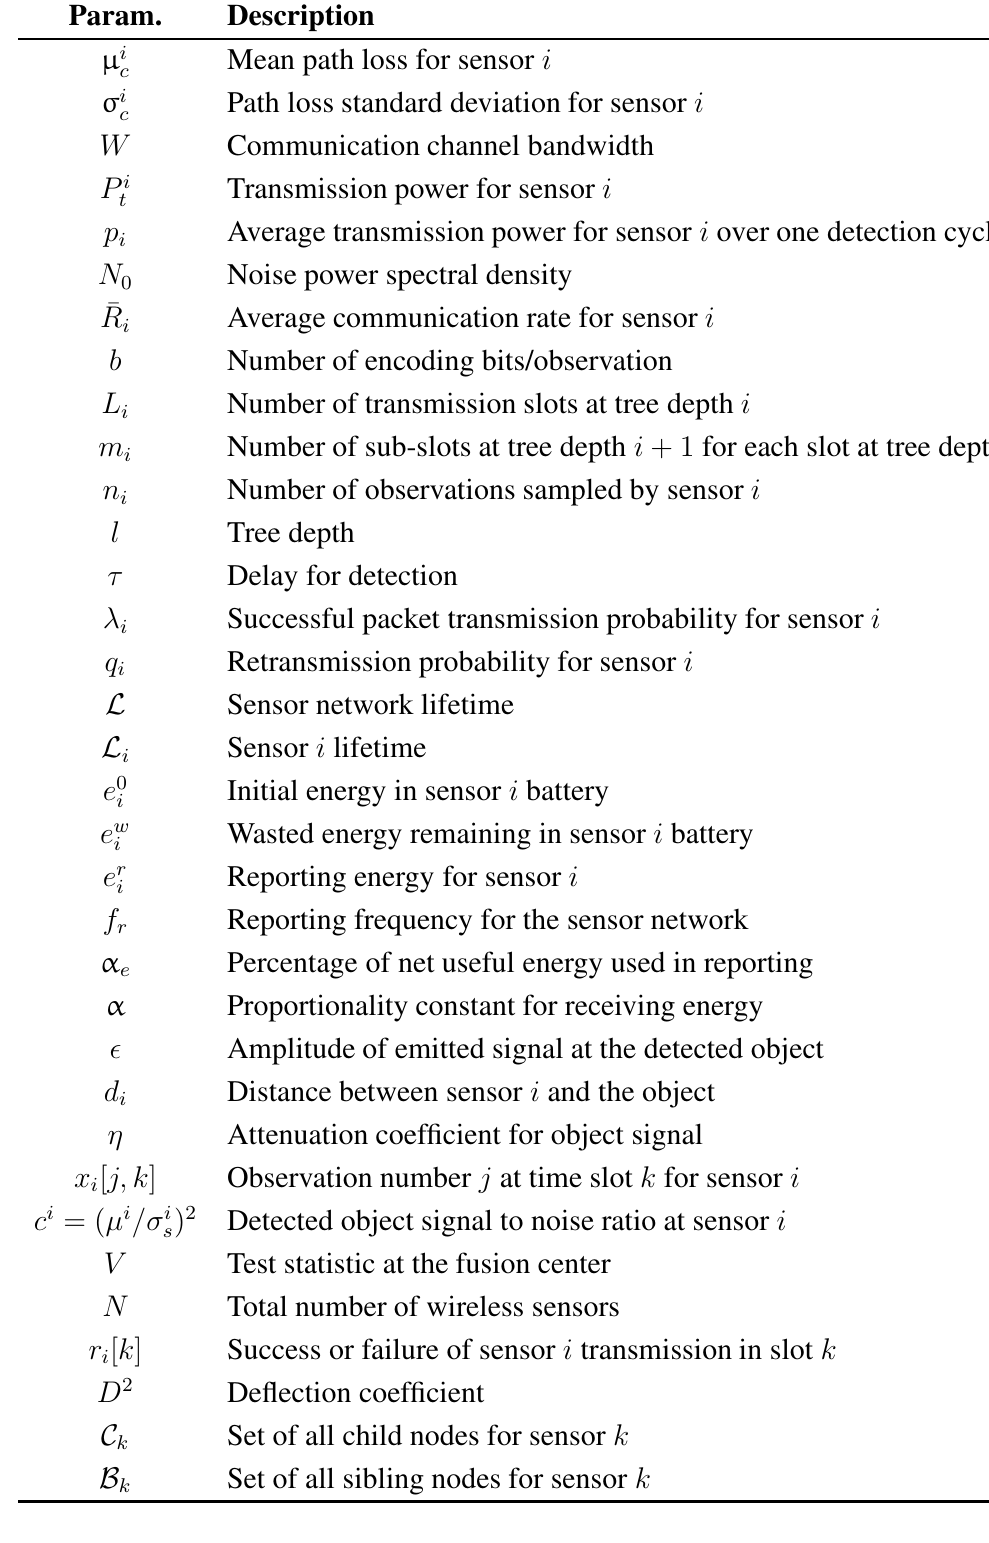
Table 1. Nomenclature for the ALOHA tree sensor network.